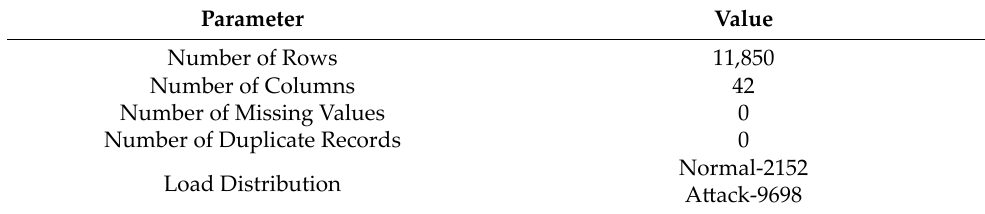
Table 7. Details of NSL_KDD Testing dataset.